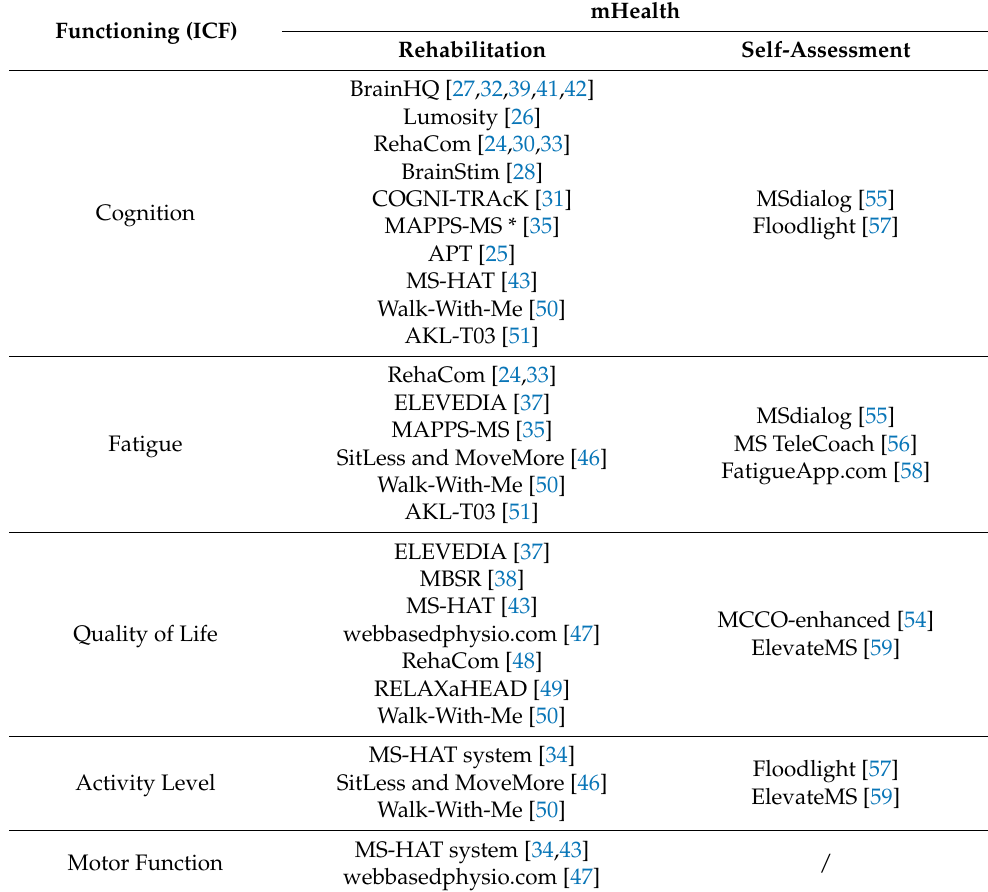
Table 3. Overview of the different mHealth solutions for rehabilitation and self-assessment according to the mean ICF